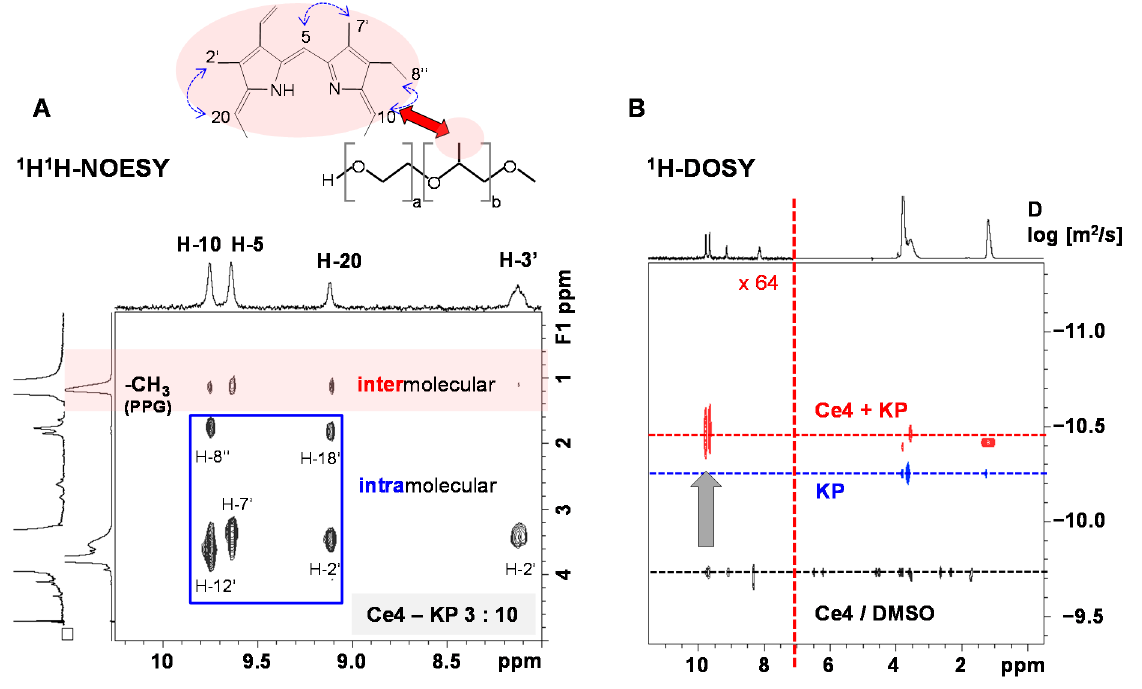
Figure 12. ( A ) 1 H 1 H-NOESY spectrum of Ce4–KP in phosphate buffered saline (PBS, molar ratio 3:10); intra molecular NOE cross peaks are visible for the Ce4 meso proton resonances (marked by the blue square) and inter molecular NOEs are visible between the Ce4 meso resonances and the methyl resonance of KP (highlighted in red and indicated in the structures); ( B ) overlay of 1 H-DOSY spectra of 3 mM Ce4 in DMSO (shown in black), 10 mM KP in PBS (shown in blue), and Ce4–KP in PBS at a molar ratio of 3:10 (shown in red). For Ce4–KP (3:10) the DOSY spectrum and the projection spectrum are scaled up by a factor of 64 in the region between 7 and 11 ppm. T = 310 K. (Reprinted from Gjuroski et al. Journal of Controlled Release, 316, (2019), 150-167 [143], © 2019 Published by Elsevier B.V., with permission from Elsevier)